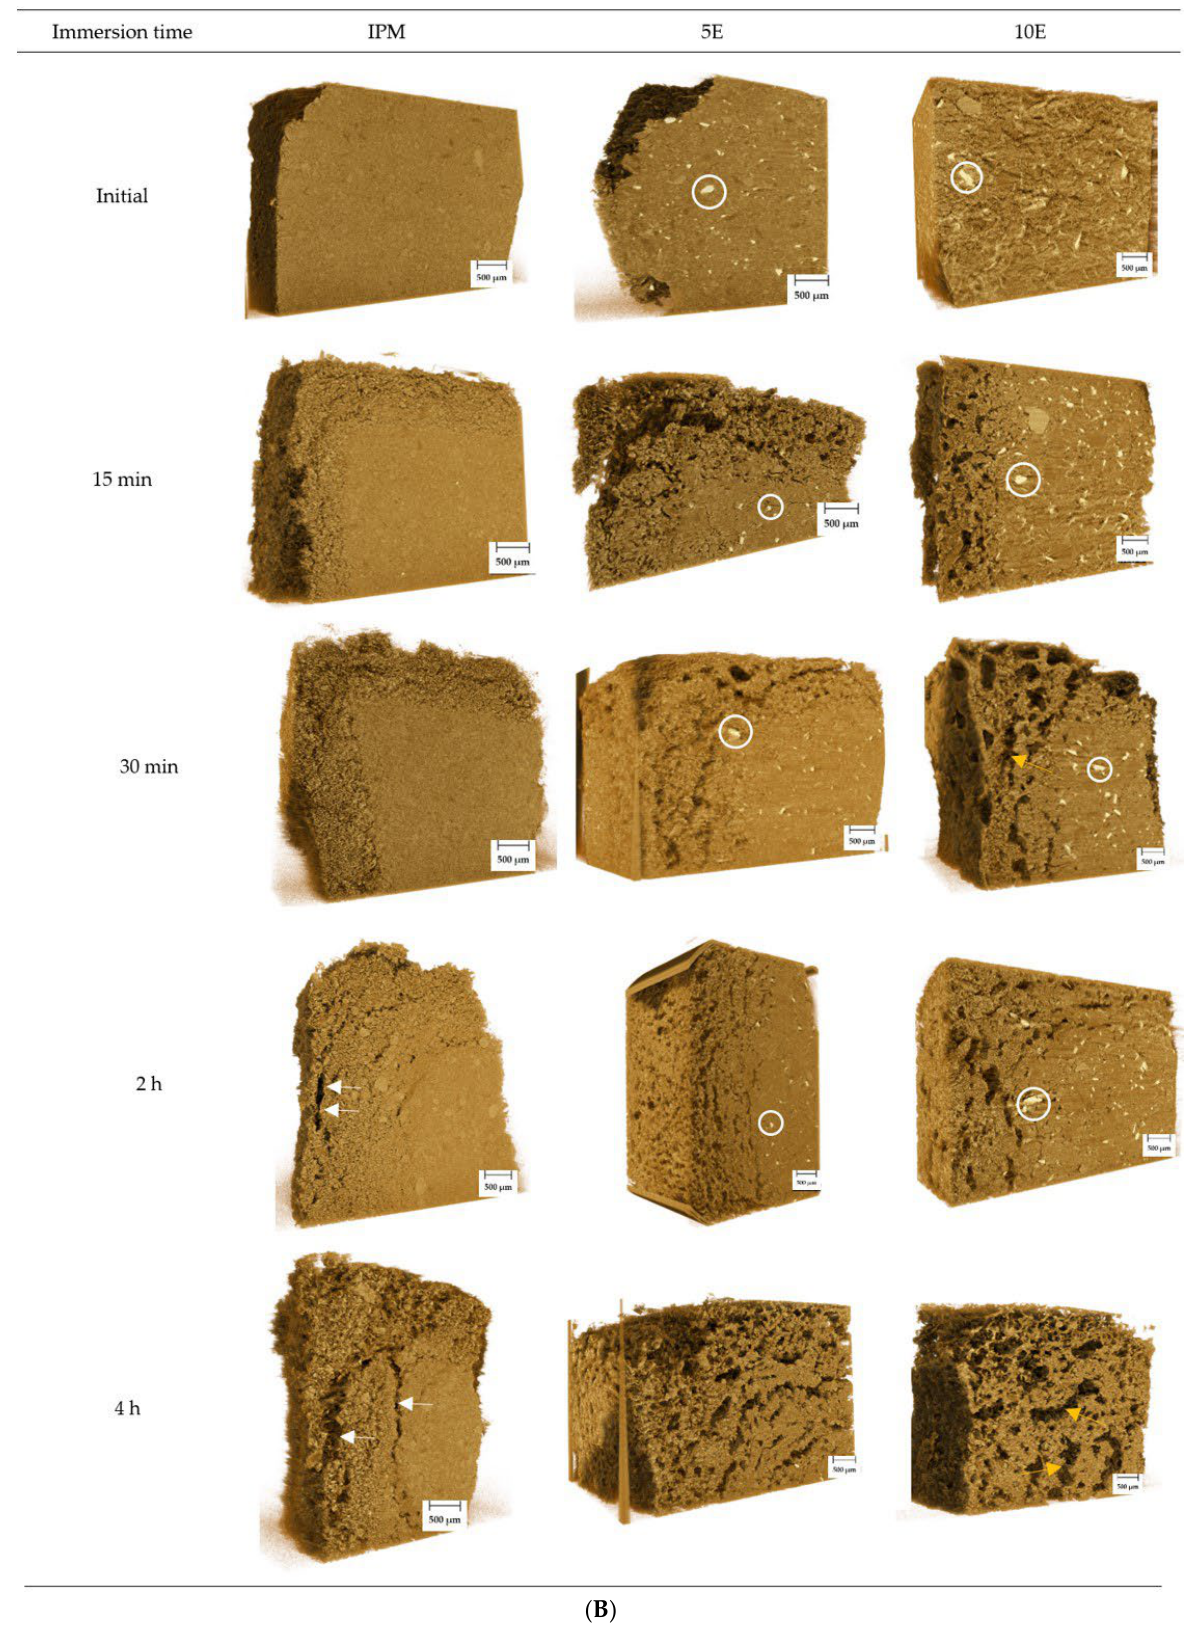
Figure 7. ( A ) Surface and ( B ) cross-sectional reconstructed 3D images of IBU-P407 effervescent matrix tablets in pH-changed media at various immersion times .